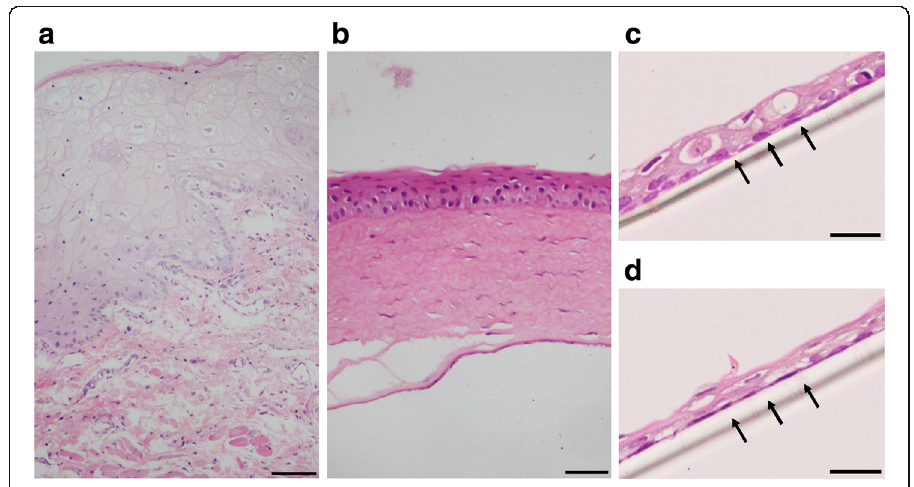
Fig. 2 Representative images of hematoxylin and eosin staining. Stratified cultivated oral mucosal epithelial cell sheets co-cultured with LNCs ( c ) and 3 T3 cells ( d ) had 2 – 3 layers after airlifting for one week. These cell sheets resembled the normal corneal epithelial cells ( b ) rather than the native oral mucosal epithelial cells ( a ). Black arrows indicate the transparent polyethylene terephthalate membrane of culture insert. Scale bars: a: 100 μ m, b: 50 μ m, c and d: 25 μ